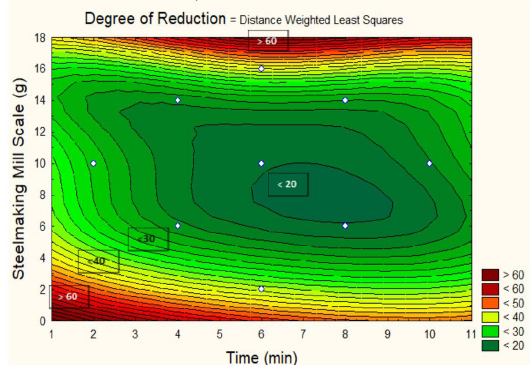
Figure 5. Contour plot of the degree of reduction as a function of the mass variation of the steelmaking mill scale and contact time of the mixture of ore, coke and scale with microwave energy.